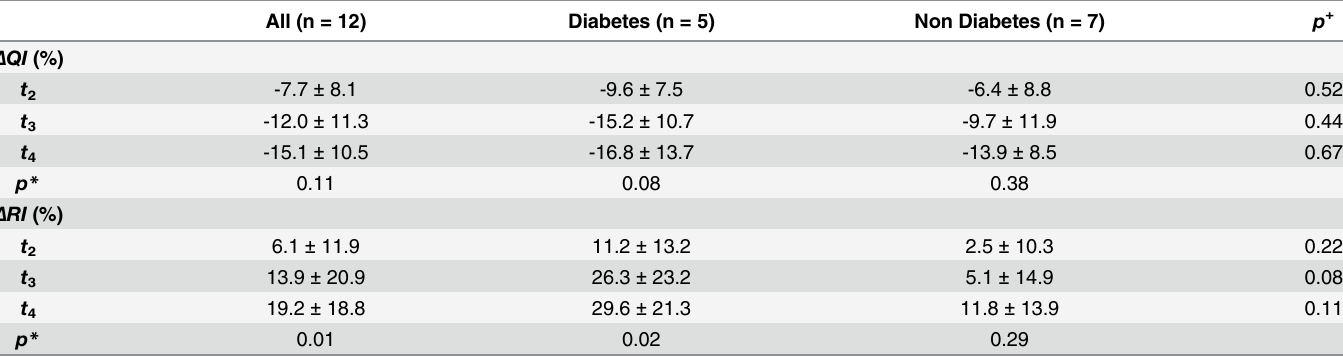
Table 3. Relative perfusion and resistance